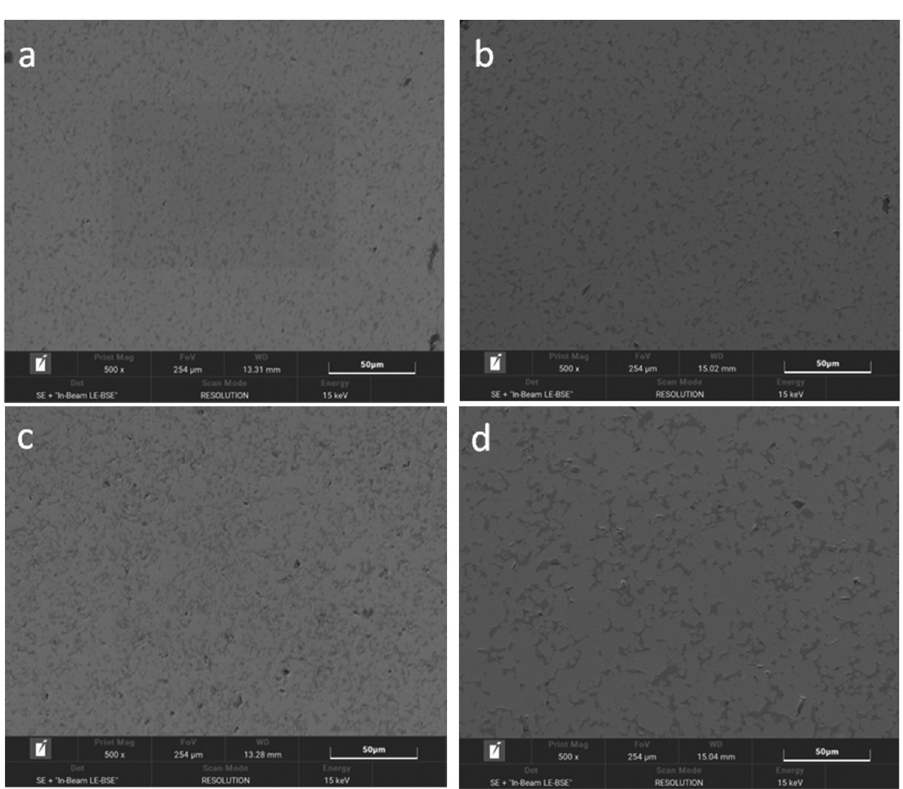
Figure 6: SEM micrograph ( s ) of NbC – Ni cermets with di ff erent dwell times ( SE + BSE mode ) : ( a ) NbC – 10Ni 5 min, ( b ) NbC – 10Ni 30 min, ( c ) NbC – 12Ni 5 min, and ( d ) NbC – 12Ni 30 min, and sintering temperature 1,390°C